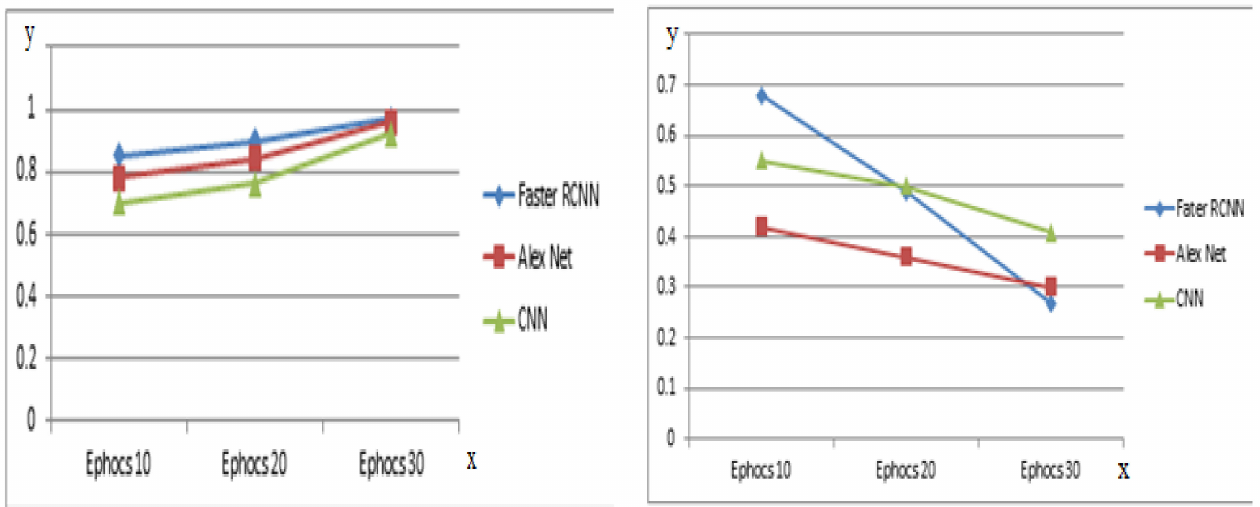
Figure 16. Accuracy and loss Comparison of three